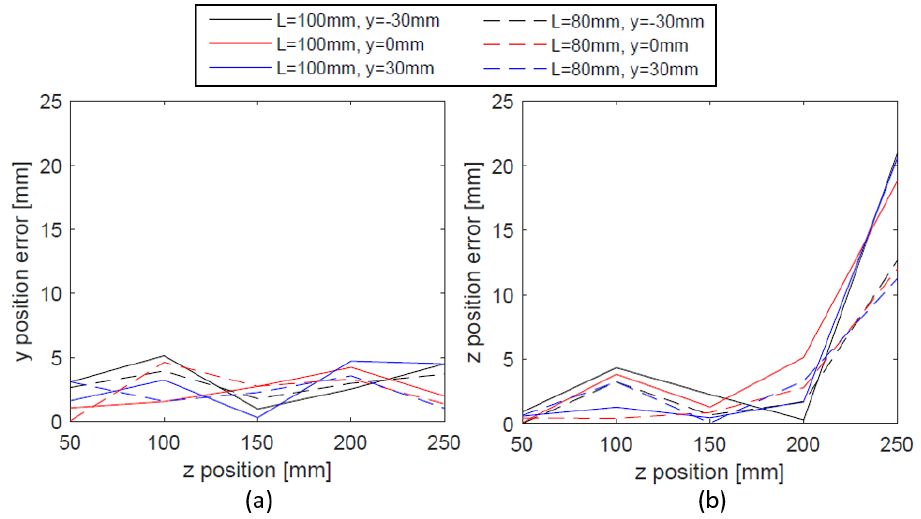
Figure 7. The average position error and SD along z-axis for ( a ) y position and ( b ) z-position. The results for both L = 80 and 100 mm are shown. Table 4. RMSE for L = 80 and 100